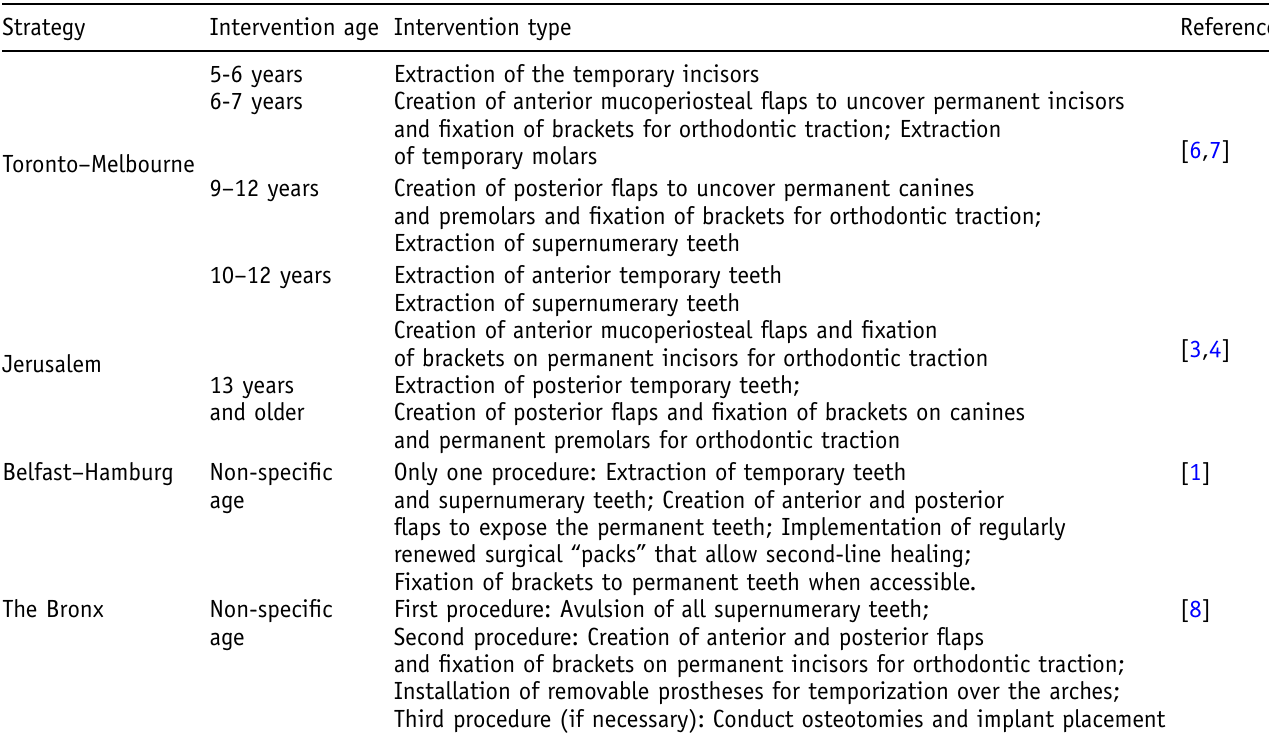
Table III. Summary of different therapeutic strategies to rectify oral impairments of cleidocranial dysplasia in the literature. Strategy